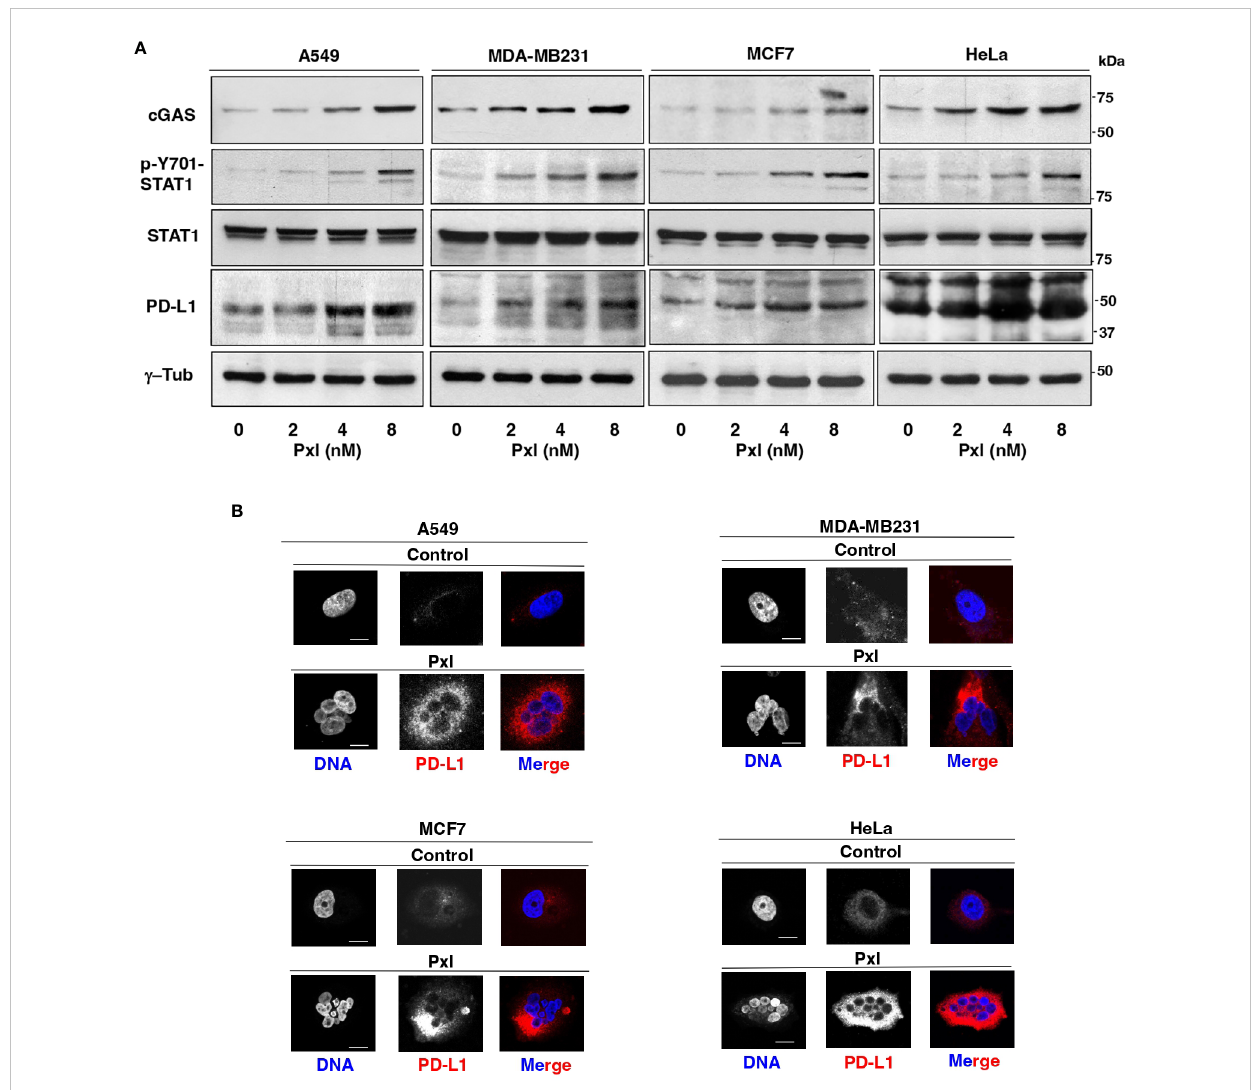
FIGURE 3 Pxl upregulates STAT1 phosphorylation and cGAS and PD-L1 protein levels in cancer cells. (A) A549, MDA-MB231, MCF7 and HeLa cells were treated for 48 hours with either vehicle (DMSO; 0 nM Pxl) or the indicated doses of Pxl (2, 4, 8 nM), lysed and proteins probed for the indicated antigens (the blots shown are representative of three independent experiments giving similar results). (B) A549, MDA-MB231, MCF7 and HeLa cells were treated for 48 hours with DMSO (Control) or 8 nM Pxl (Pxl). Cells were fi xed and processed for indirect PD-L1 immuno fl uorescence and DNA staining. Scale bar: 5 m